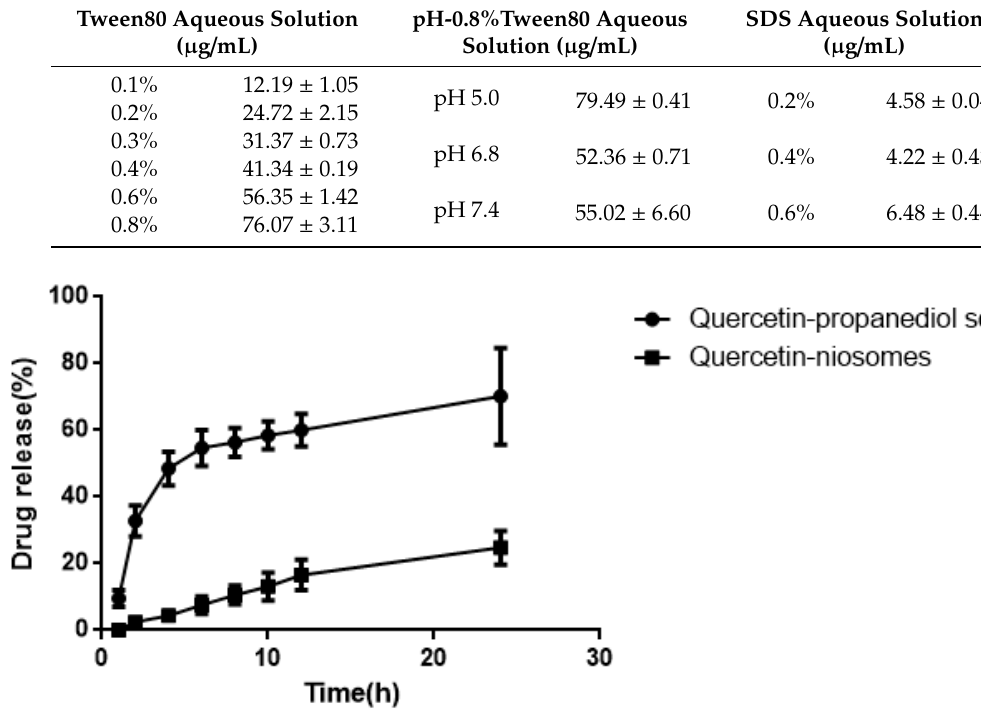
Figure 9. Release behavior of quercetin-propanediol solution and quercetin-niosome in 0.8% Tween80 (pH 5.0).